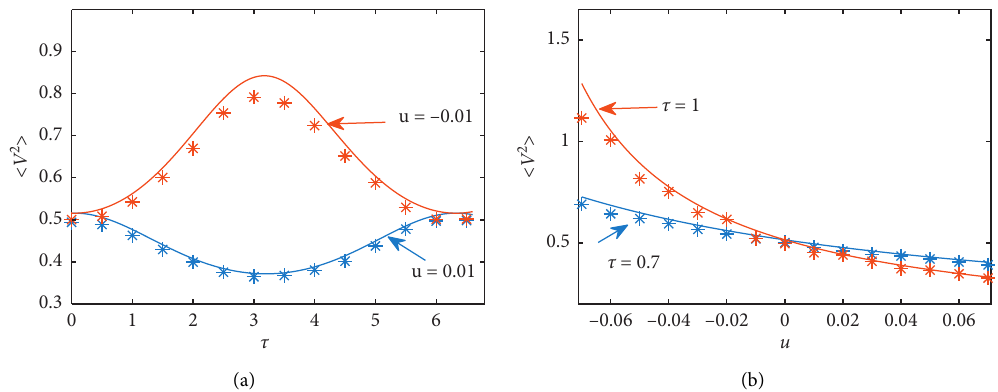
Figure 6: The influences of time delay and feedback strength on the MSEV. Theoretical analysis results (solid line) and Monte Carlo simulation results ( ∗ ).